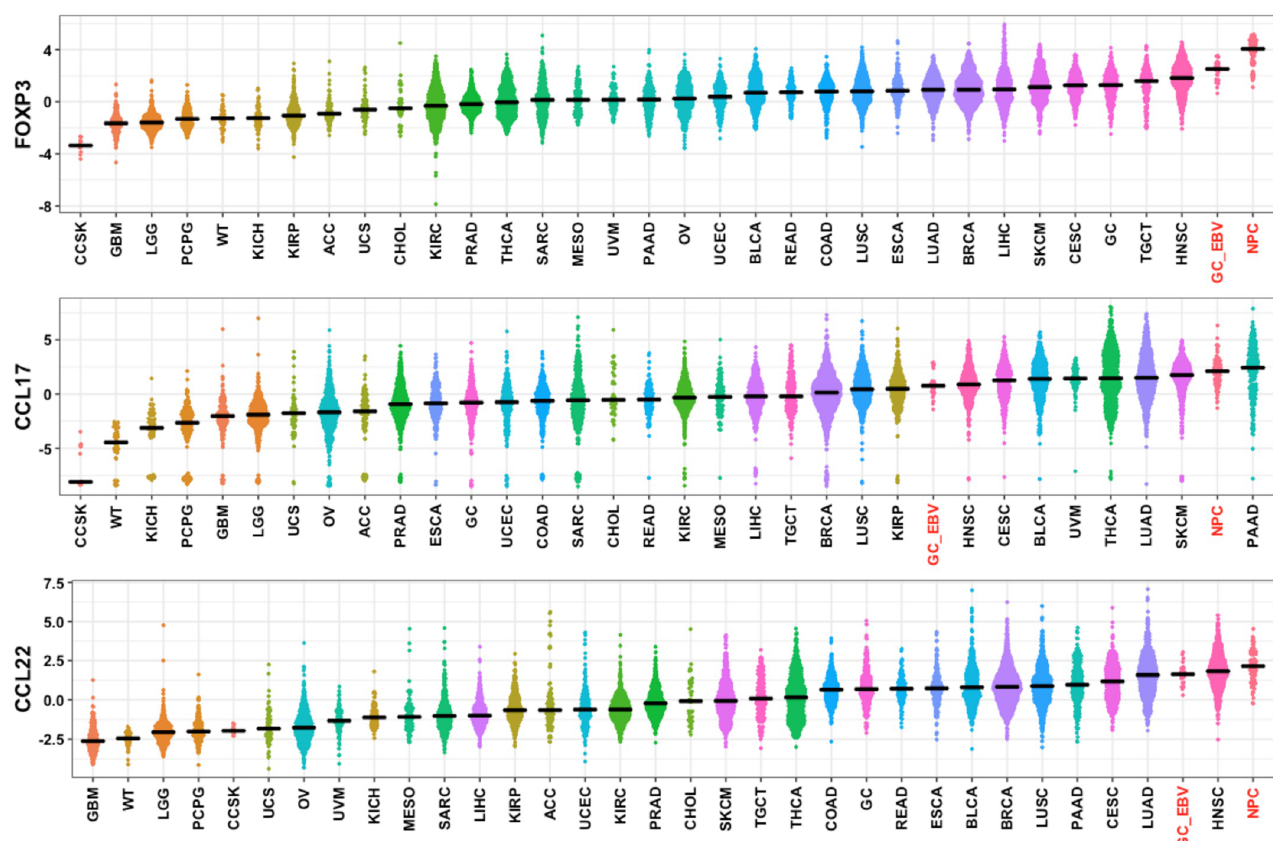
Fig 3. FOXP3 and CCR4 ligand expression is elevated in EBV + tumors. (A) RNA-Seq data from 76 Nasopharyngeal carcinomas (NPC) was normalized with data from TCGA and TARGET and analyzed for expression of genes of interest. TCGA Gastric carcinoma samples were divided into EBV - (GC) and EBV + (GC_EBV) subsets. EBV + tumor types NPC and GC_EBV are highlighted in red. Other tumor abbreviations are defined in S1 Table. Tumor types are sorted by increasing median expression and plotted as log 2 Transcripts per Million.